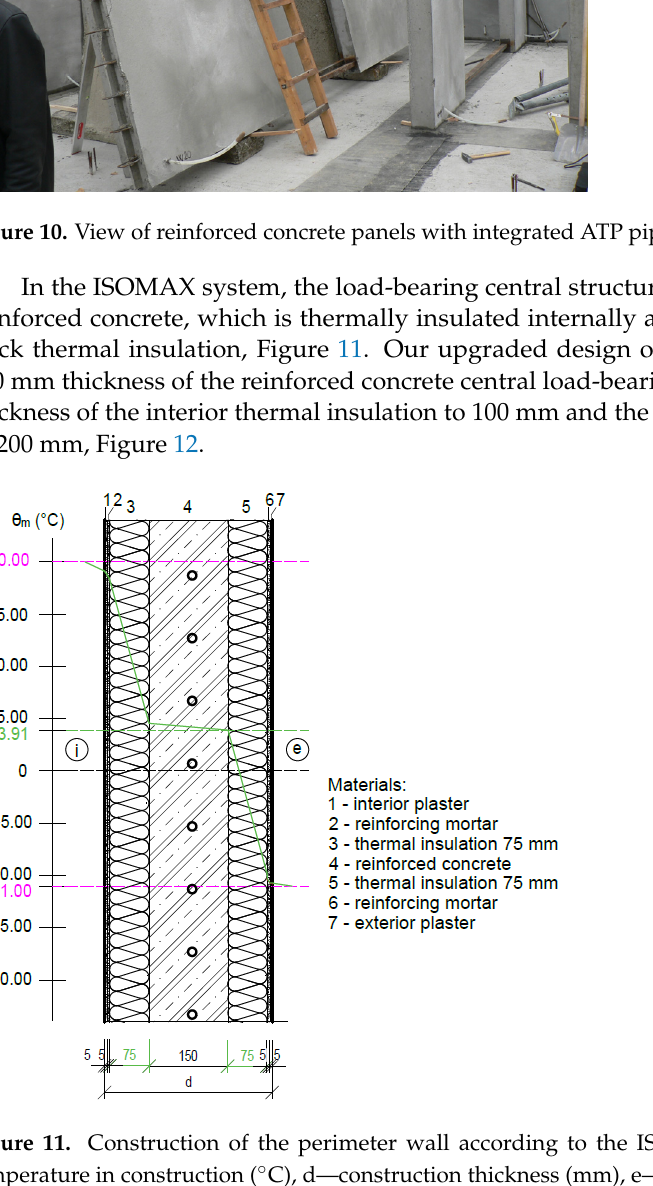
Figure 11. Construction of the perimeter wall according to the ISOMAX system [5]. θ m —the temperature in construction ( ◦ C), d—construction thickness (mm), e—exterior, and i—interior.